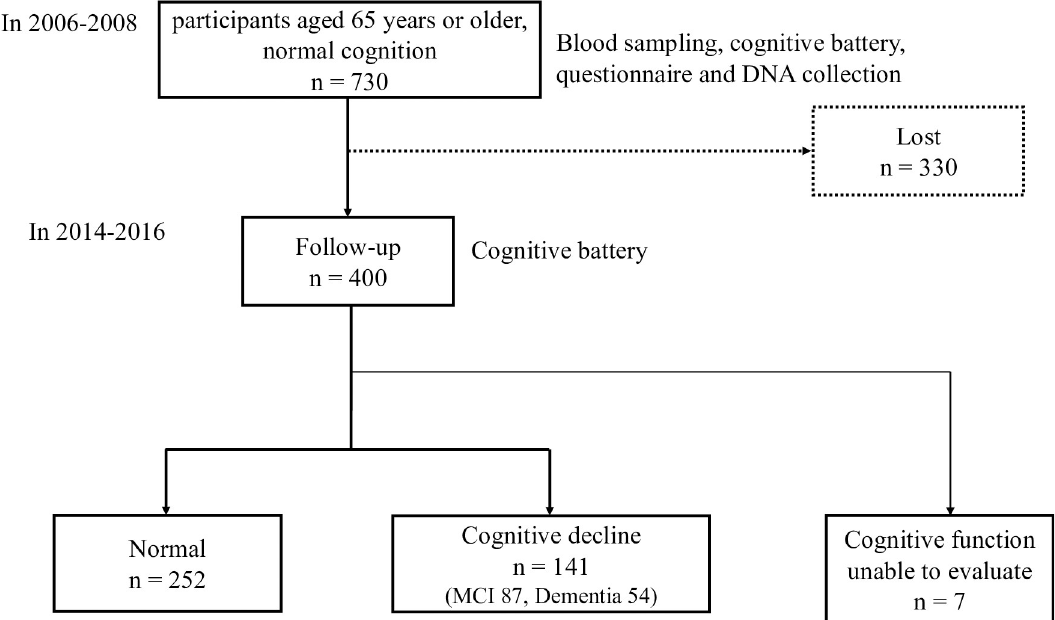
Fig 1. Design of the case–controlled study. Baseline survey was conducted between 2006 and 2008. The participants aged 65 years or older with normal cognition were selected. In the baseline survey, participants took cognitive battery, underwent blood sampling, and responded to a questionnaire, including medical history. DNA was extracted from the blood. Between 2014 and 2016, follow-up survey was conducted, and the cognitive status was evaluated again. Based on the cognitive status, the participants were classified into normal group (normal cognition) or cognitive decline group (MCI or